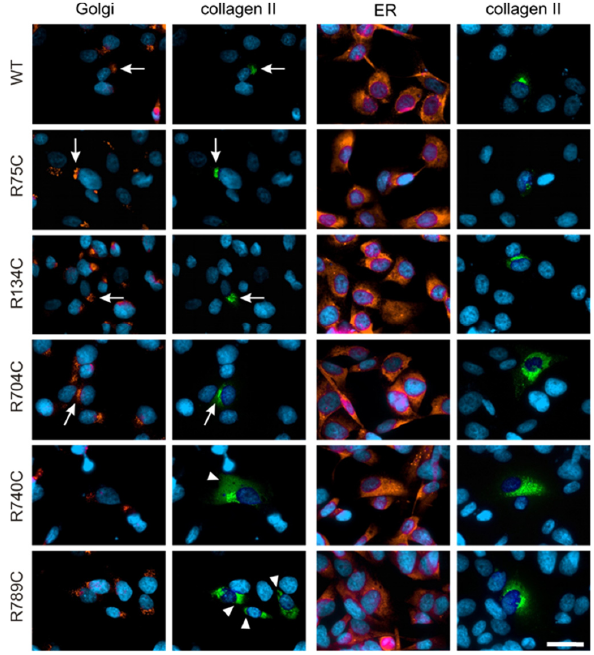
Figure 4. Immunofluorescence microscopy of transfected HT1080 cells showing the intracellular localization of wildtype and mutant collagen II variants. HT1080 cells transfected with collagen II constructs were analyzed three days post-transfection with antibodies directed against the myc epitope of collagen II (green) and either against PDI as a marker for ER or 58K as a marker for the Golgi apparatus (both in red). Colocalization of collagen with 58K in the Golgi compartment is seen in cells expressing WT, R75C, R134C and R704C collagen (arrows). In cells expressing R740C and R789C collagens, significant amounts of protein colocalize with PDI in the ER detected outside the Golgi apparatus (arrowheads). Scale bar, 25 µm.